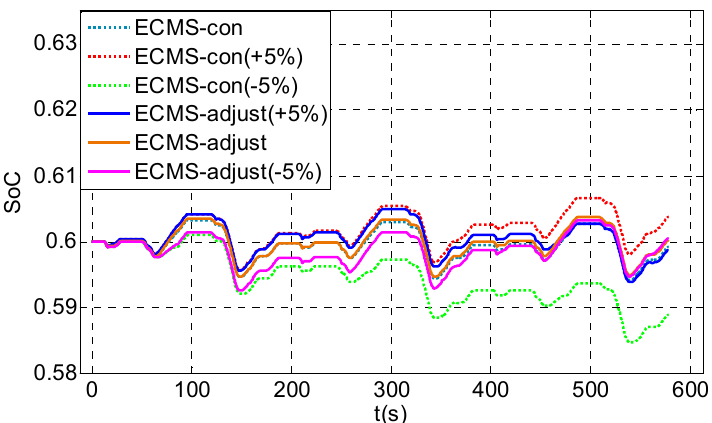
Figure 15. SoC trajectories for different control strategies (3 × Economic Commission of Europe (ECE)). Note: ECMS-con: ECMS with optimal EF; ECMS-con ( ± 2%/ ± 5%): ECMS with EF when deviations are added to the optimal value; ECMS-adjust: ECMS with fuzzy PI controller; ECMS-adjust ( ± 2%/ ± 5%): ECMS with a fuzzy PI controller adjusted with EF when deviations are added to the initial value; CHA: china city bus cycle.